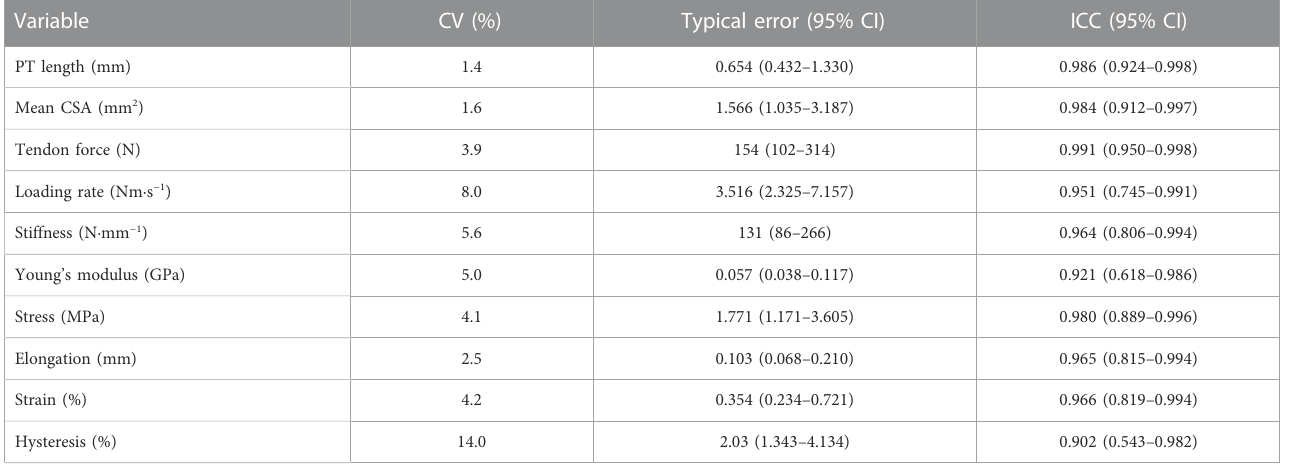
TABLE 3 Test-retest reproducibility of morphological, mechanical and material tendon properties.